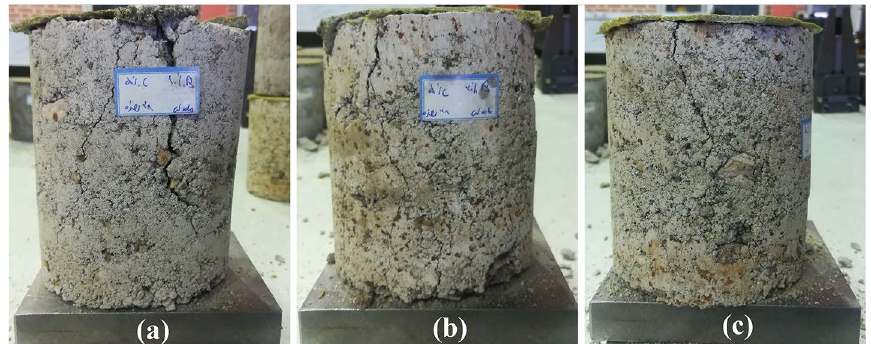
Fig. 12 The failure mode of CSG mixtures with 5% cement, cured at age 28 day and containing: a 10% bentonite (S-C5-B10 sample), b 20% bentonite (S-C5-B20 sample), c 3 0% bentonite (S-C5-B30 sample)